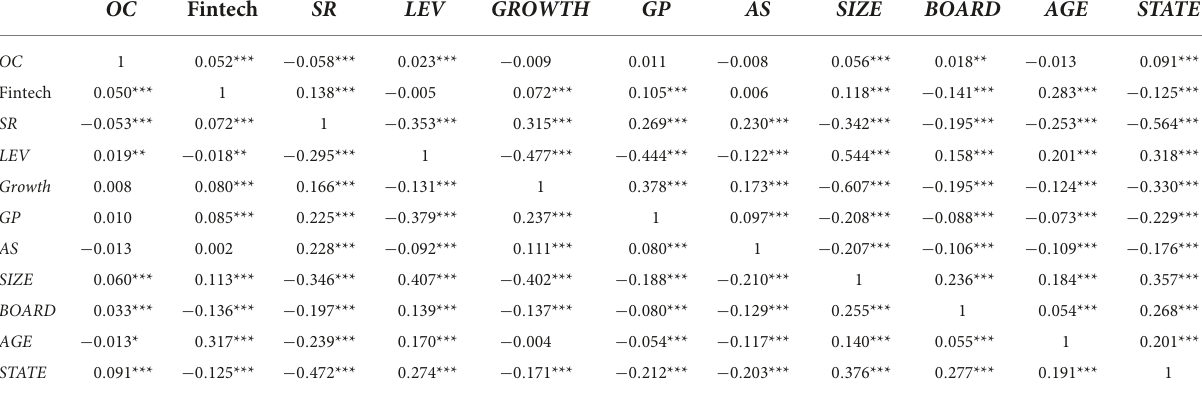
TABLE 3 Correlation coefficient matrix.